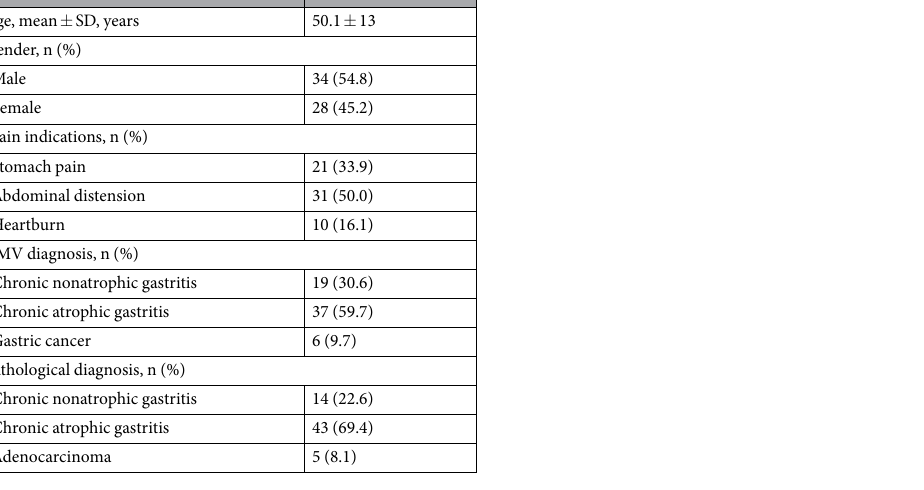
Table 1. Demographic and clinical data.